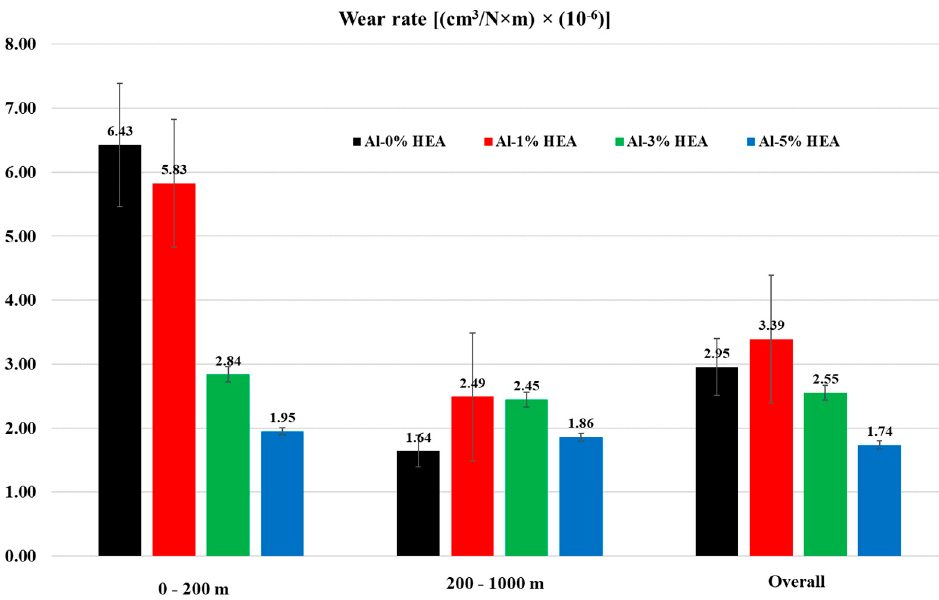
Figure 10. Wear rates for the initial 200 m, 200 to 1000 m and overall distance of each composition.